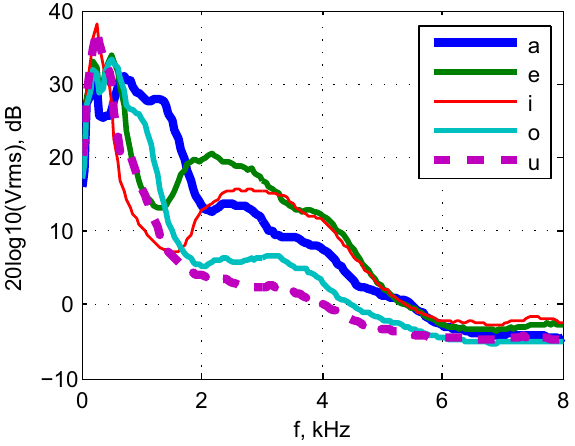
Figure 9. VCV logatomes: average RMS normalised spectra of left